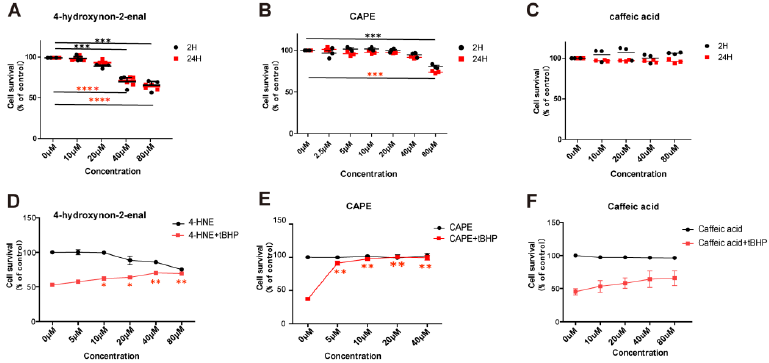
Figure 4. The molecular structures of 4-Hydroxynon-2-enal (4-HNE), caffeic acid phenyl ester and caffeic acid. Adapted from Reference [60].